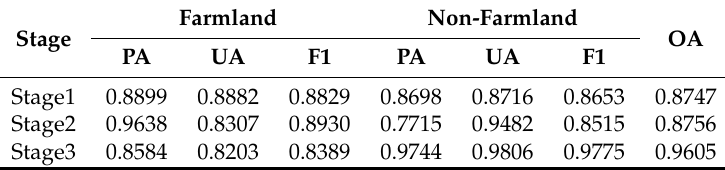
Table 4. Comparision of classification performance between stage 1, stage 2 and stage 3.